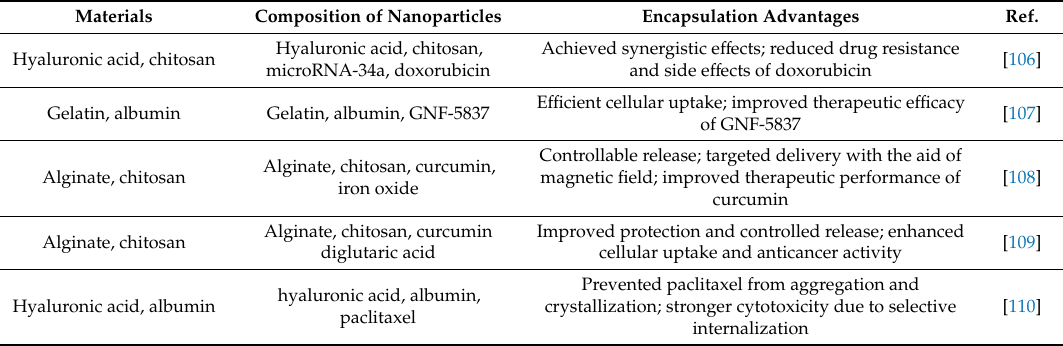
Table 3. Examples of co-natural polymer-based